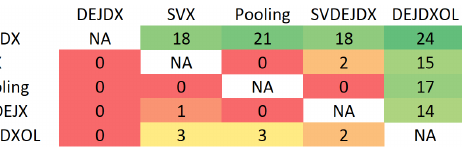
Figure 12. The results of the Diebold-Mariano tests at a significance level of 0.05 and for 24 h of the day with the pinball 50% middle scoring rule in the out-of-sample period (2 January 2017–26 March 2017).